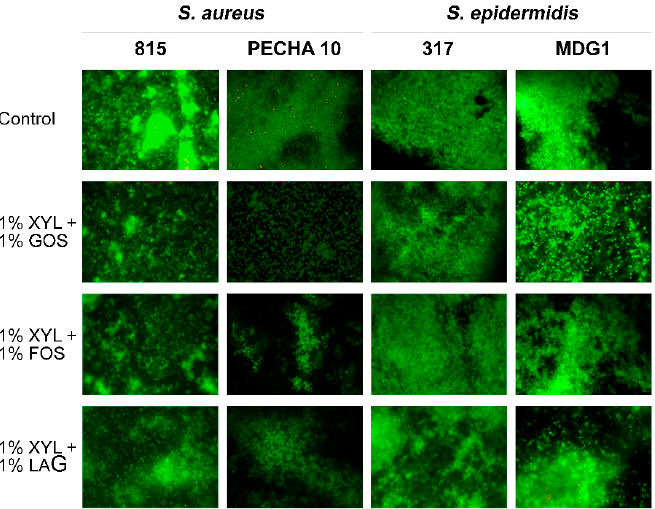
Figure 5. Representative LIVE/DEAD images of S. aureus 815, S. aureus PECHA 10, S.